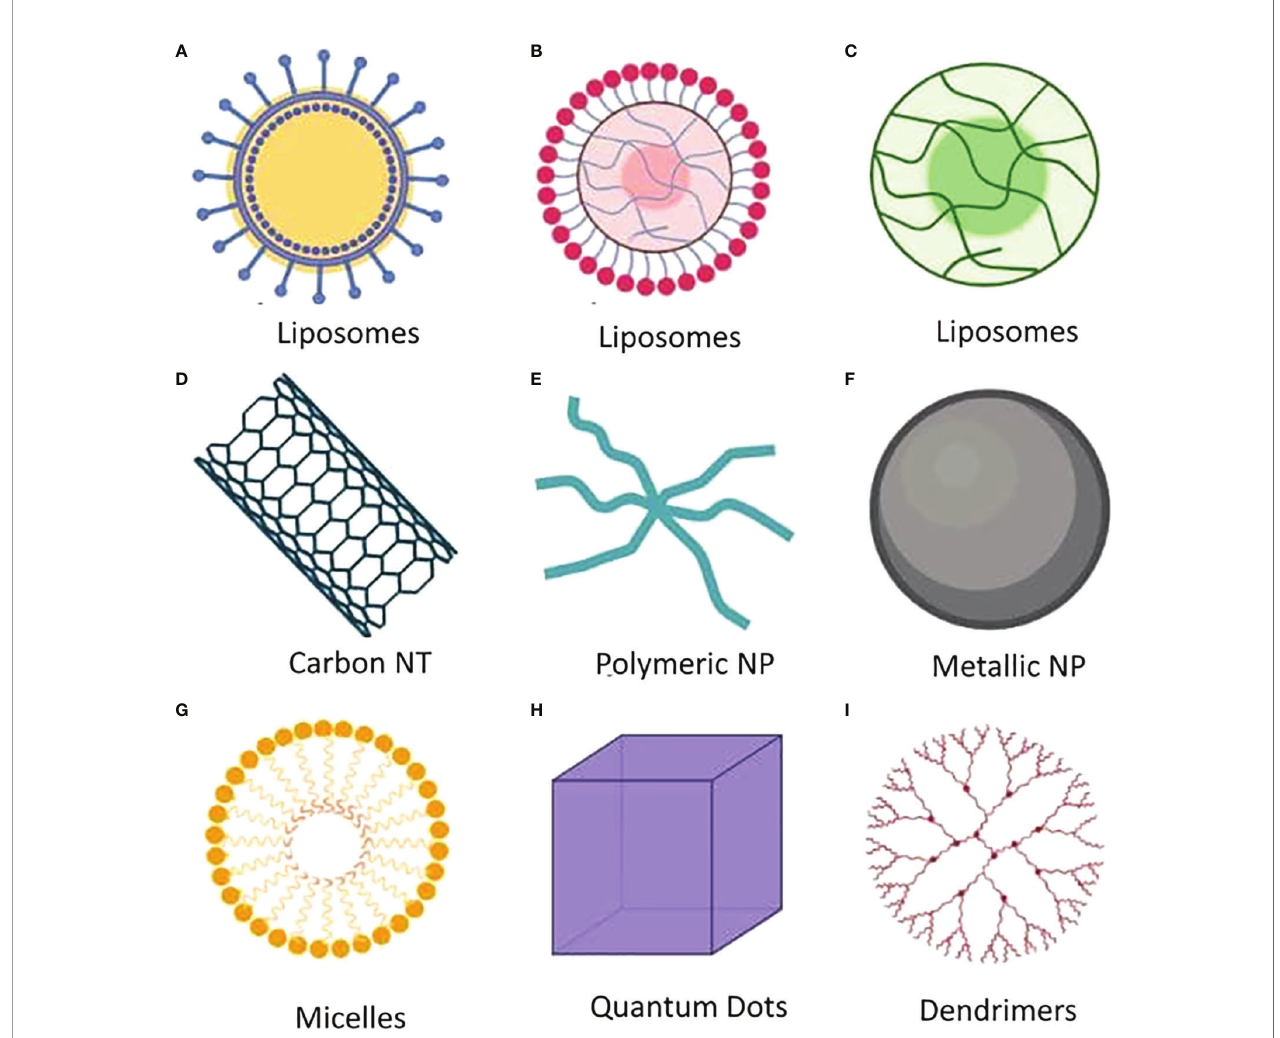
FIGURE 6 | Notable nanoparticles that have several applications in the fi eld of medical sciences. (A) Multilamellar liposomes which have several phospholipid bilayer spheres. (B) Large unilamellar liposomes which have single phospholipid bilayer sphere and size of 200 to 800 nm. (C) Small unilamellar liposomes which also have single phospholipid bilayer sphere and size of less than 100 nm. (D) Carbon nanotubes are made of sheets of single-layer carbon atoms. (E) Polymeric nanoparticles which have size ranging from 1 to 1000 nm and also known as colloidal solid particles. (F) Metallic nanoparticles are made of metal as core and organic compound or inorganic metal as sphere. (G) Micelles are composed of amphiphilic macromolecules which range from 5 to 100 nm as nanoparticle. (H) Quantum dots are ultrasmall semiconductor nanoparticle. (I) Dendrimers are nanoparticle organized with core, inner shell and outer